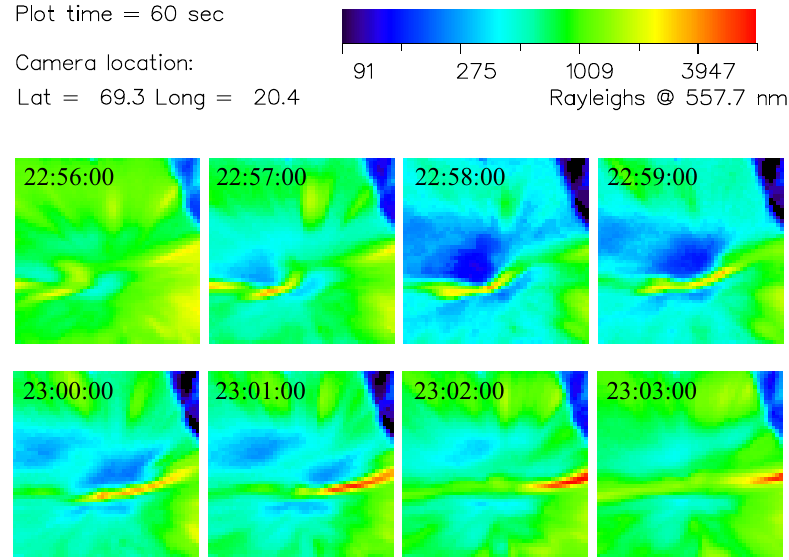
Fig. 9. All-sky images with a time resolution of 1min, around the time when a dark spot was observed.